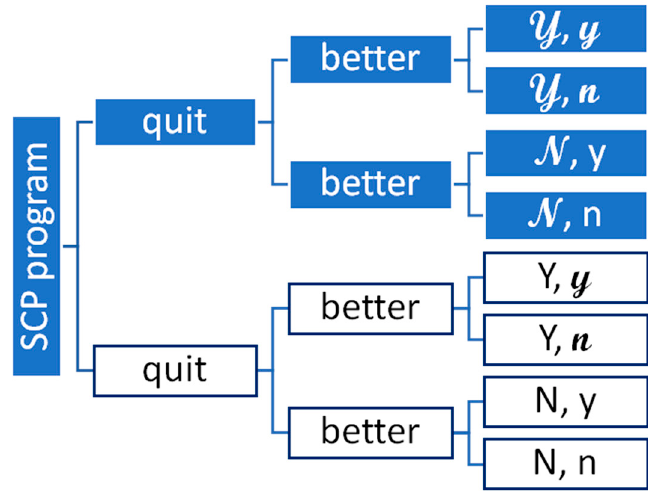
Table 1. Notation for quitting probabilities as well as doing better probabilities by program *.